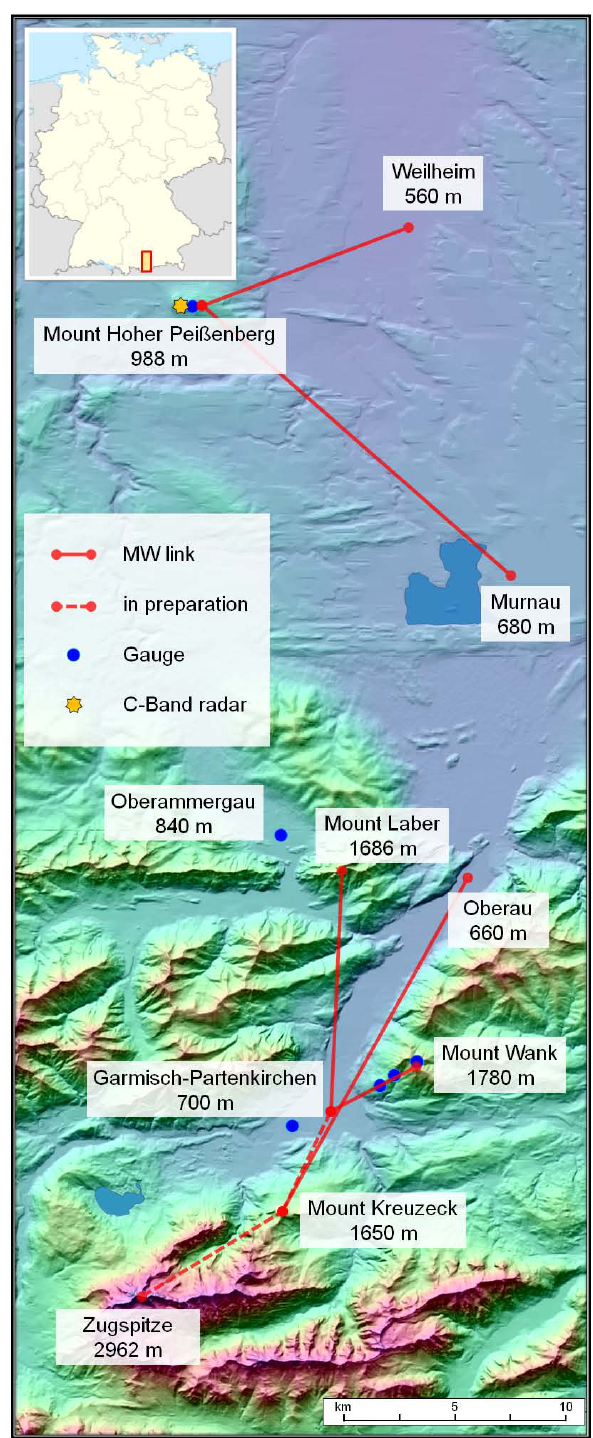
Fig. 2. Overview of the study region in Southern Germany showing the location of the DWD C-band radar, all microwave links and all rain gauges used in this